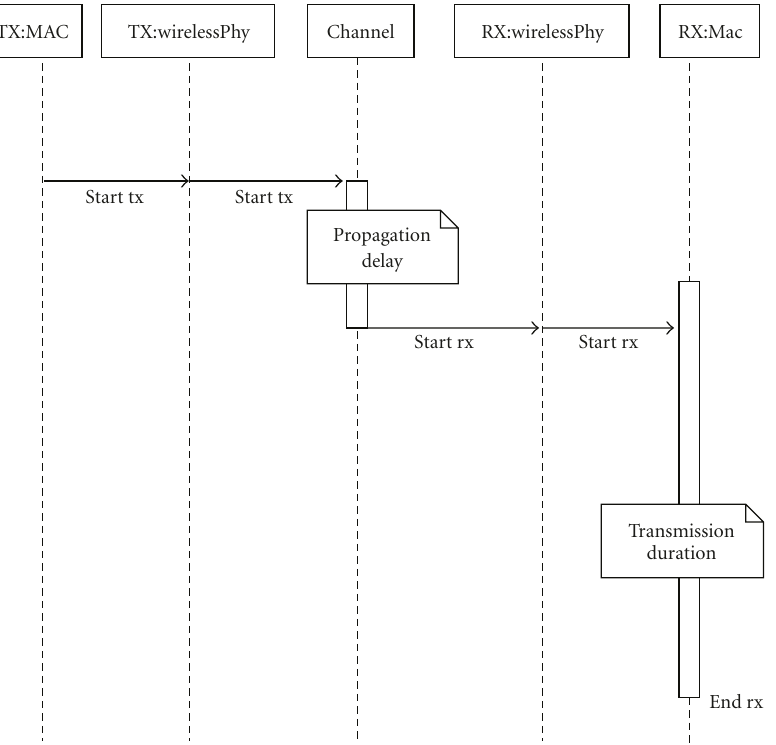
Figure 4: Sequence diagrams for packet TX/RX events in the ns2 MobileNode .